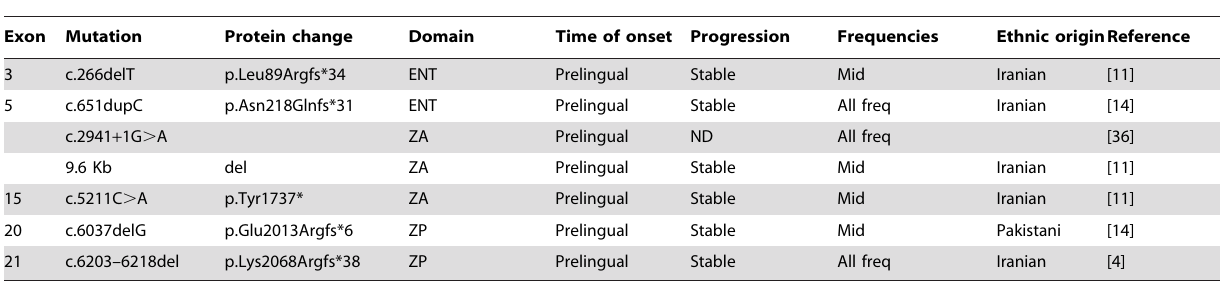
Table 2. DFNB21 TECTA mutations and the associated